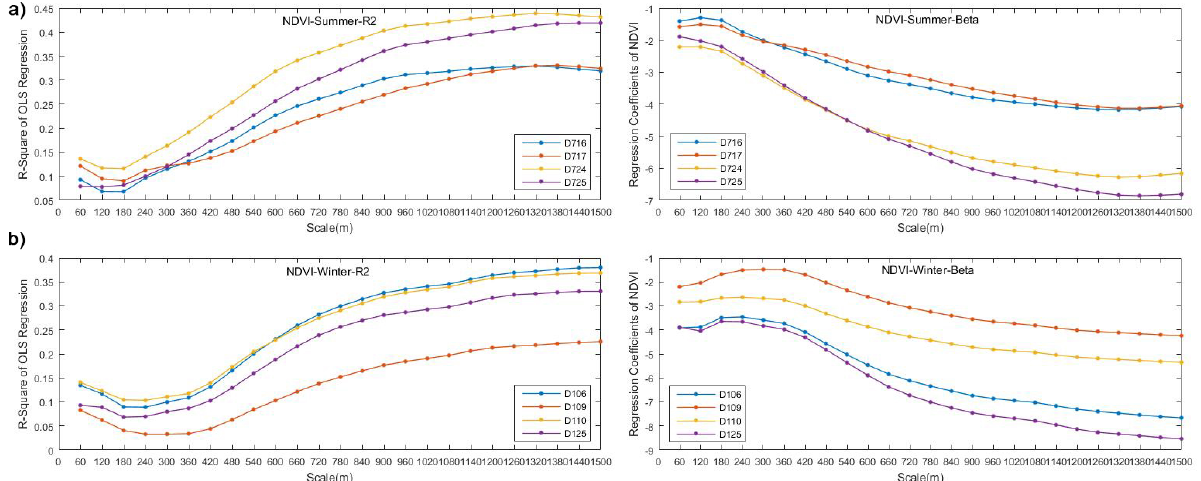
Fig 4. Scalograms showing the scaling effects on NDVI-AT relationships: a) the R 2 and the coefficients of the bivariate model between NDVI and AT in summer; b) the R 2 and the coefficients of the bivariate model between NDVI and AT in winter.